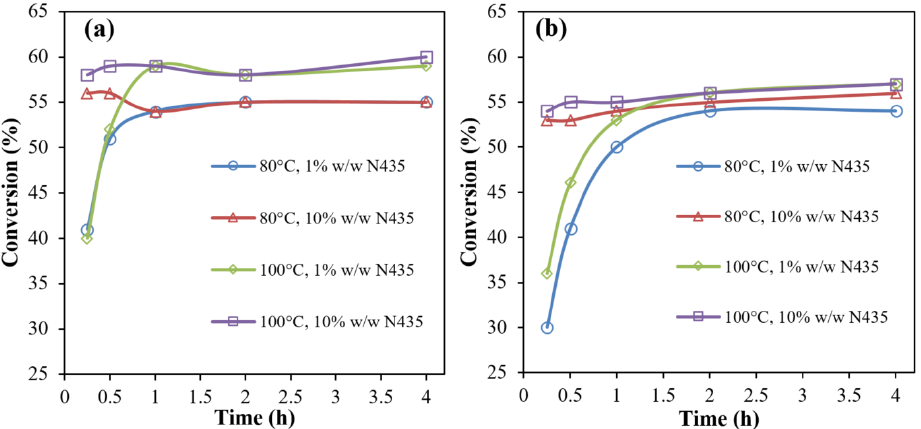
Figure 1. Conversion (expressed in %) after oligomerization step calculated via 1 H NMR as a function of temperature and enzyme loading in bulk ( a ) and diphenyl ether ( b ) conditions.